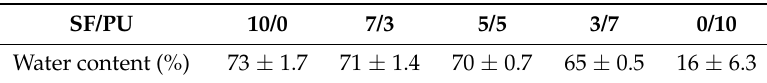
Table 3. Percentage water content of non-woven sheets.